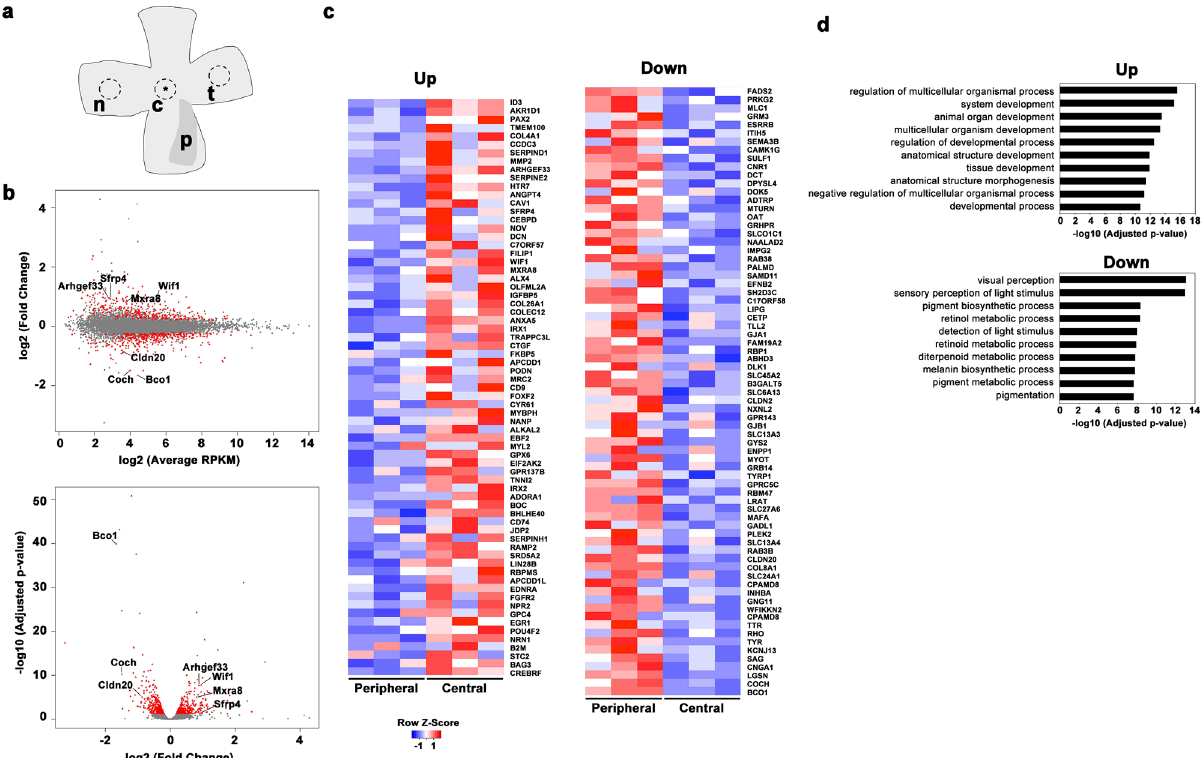
Figure 3. Expression profiles in the fovea. ( a ) A schematic depicting the areas where the punches were collected for RNA-seq analysis. The punch size was 1.5 mm in diameter. A fovea is marked by an asterisk. c, central; p, pecten; n, nasal; t, temporal. ( b ) The differences in gene expression profiles in between the fovea and the periphery are displayed in a MA plot (upper panel) and a volcano plot (lower panel). In the MA plot, M is log2 (FC), and A is log2 (average RPKM). In the volcano plot, X-axis denotes log2 (FC) and Y-axis denotes − log10 (adjusted p-value). Red color indicates genes with significant adjusted p-values (< 0.05). ( c ) A heat map of the genes with significant alterations in expression between the central and peripheral retina for the up-regulated and down-regulated genes (right and left panels). The peripheral retina contains both nasal and temporal retinal regions. Gene expression values were z-transformed for visualization using color scale from blue to red. ( d ) The top 10 most significantly enriched biological processes determined by gene ontology enrichment analysis for up-regulated and down-regulated genes (upper and lower panels). X-axis is − log10 (adjusted p-value) and Y-axis is biological